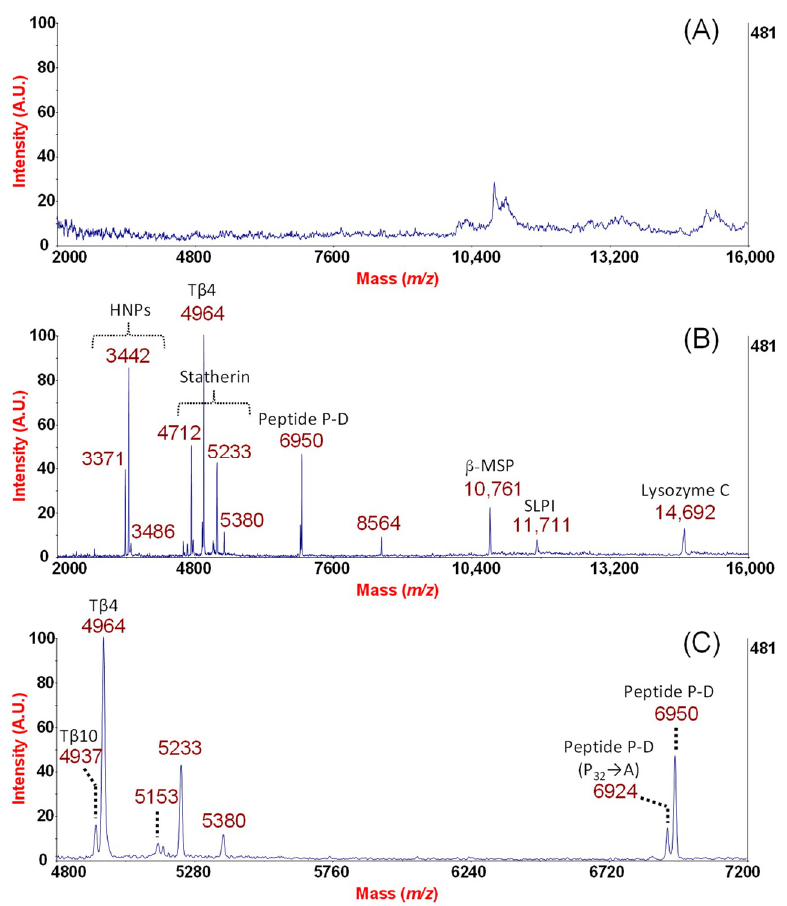
Figure 1. MALDI-TOF mass spectra of NF before ( A ) and after processing by MPS-C ( B ). A nasal swab collected nasal fluid (NF) from one healthy participant in the study and 30% of sodium chloride was used as eluent ( A ). The eluate was then incubated with the MPS particles for the selective enrichment of nasal antimicrobial peptidome. MALDI measurements were performed in sinapinic acid (SA) and the spectra were recorded in linear mode in the m / z range 2000–20,000. Molecular mass windows are shown in the m / z range between 2000 and 16,000 and ( B ) between 4800 and 7200 ( C ).